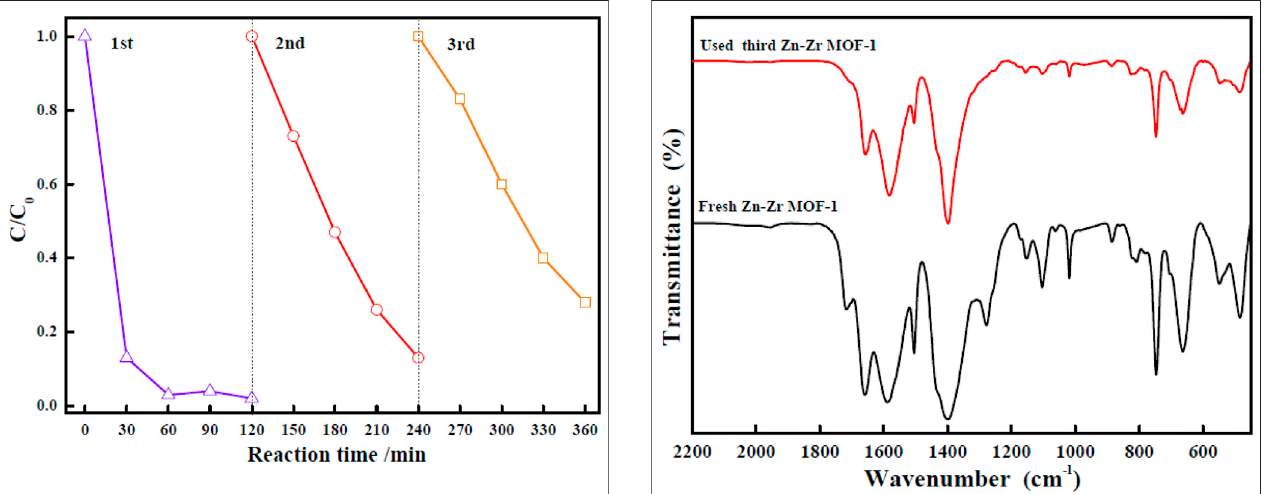
FIGURE 8 | Recycling test of Zn-Zr MOF-1 in the photocatalytic degradation of RhB. FIGURE 9 | FTIR spectra of fresh and reused Zn-Zr MOF-1 catalyst.